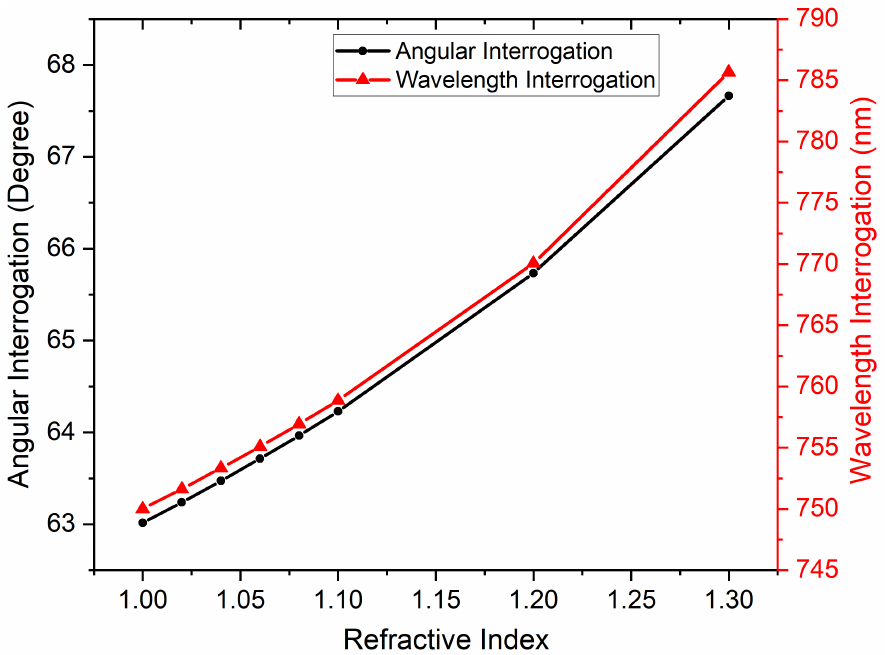
Figure 6. Comparative sensitivity analysis of both angular and wavelength interrogation